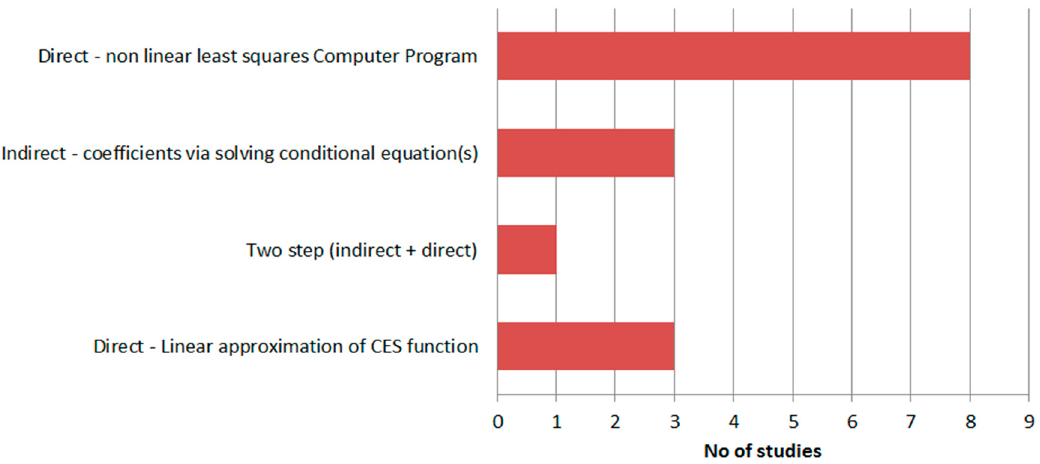
Figure 5. CES estimation method in sample papers.